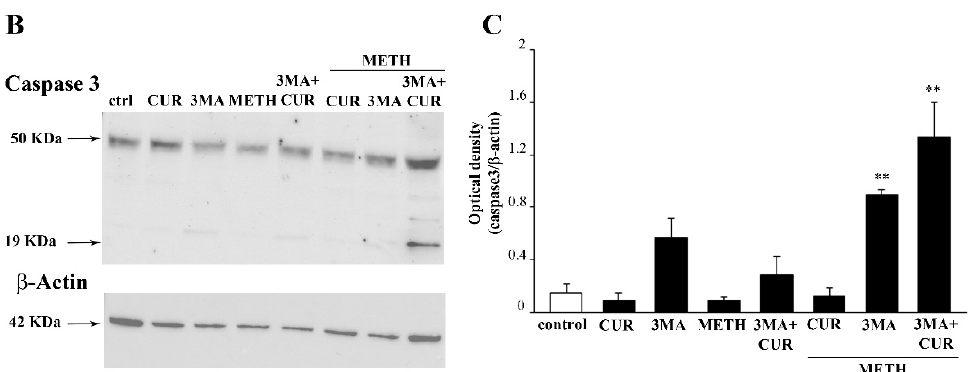
Figure 18. Inhibition of autophagy precipitates apoptotic cell death in METH-treated cells. ( A ) Representative pictures of caspase 3-immunofluorescent cells in PC 12 cells treated with CUR 10 µ M, METH 100 µ M, and the autophagy inhibitor 3MA. Immunoblotting for caspase 3 ( B ) and the related optical density graph ( C ) The primary antibody recognizes the cleaved form of caspase 3. Blot at 50 kDa represents non-specific caspase 3 substrates which are also detected at WB. Arrows indicate caspase 3 positive cells. ** p ≤ 0.05 compared with control and METH. Scale bar = 7.3 µ M.